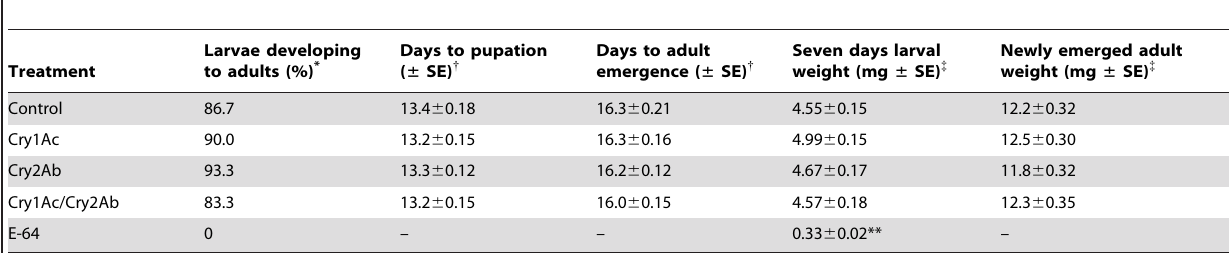
Table 2. Impact of purified Cry1Ac, Cry2Ab and E-64 provided in artificial diet on survival and development of Coleomegilla maculata .